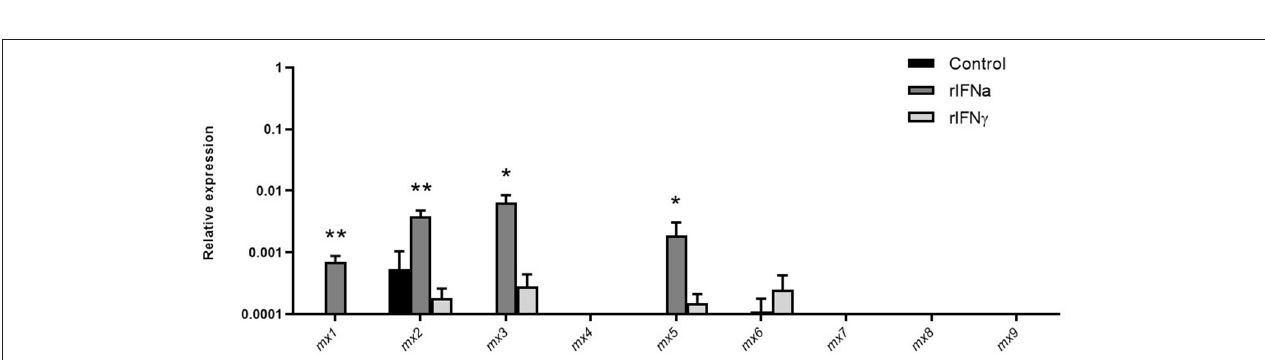
FIGURE 6 | specific mAb against trout MHC-II. A representative histogram is shown together with a graph of the mean MHC-II MFI values for IgM + IgD + B cells (A) or IgM − IgD − cells (B) (mean + SEM; n = 9). In another experiment, blood leukocytes were treated with the rIFNs as described above and after 24h IgM + IgD + B cells were sorted by flow cytometry. RNA was extracted to determine the levels of transcription of mhcII , cd83, and cd80/86 (C) by real time PCR. Gene expression data were normalized against the endogenous control b-actin and are shown as relative expression (mean + SEM; n = 10). Asterisks denote significant differences between samples treated with rIFNs and control samples (* P ≤ 0.05 and ** P ≤ 0.01).